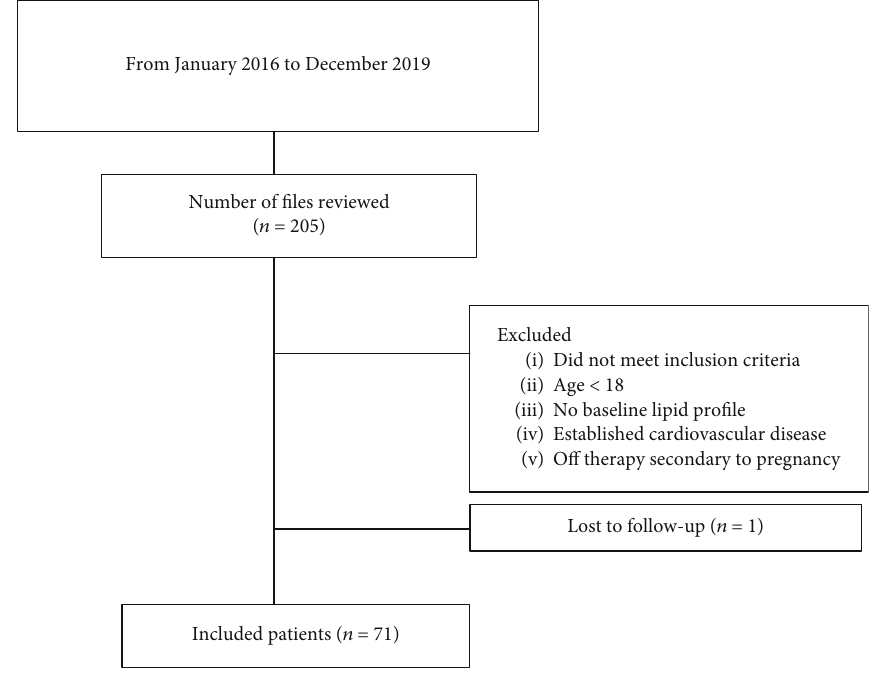
Figure 1: Study design: patient selection. Table 2: Clinical characteristics at baseline: demographics.